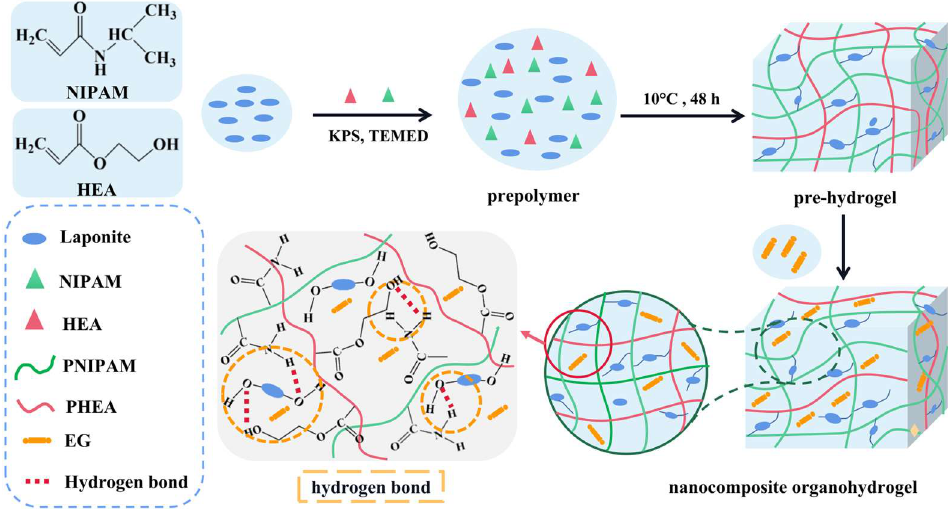
Figure 1. Schematic diagram of preparation of Laponite NC organohydrogels.